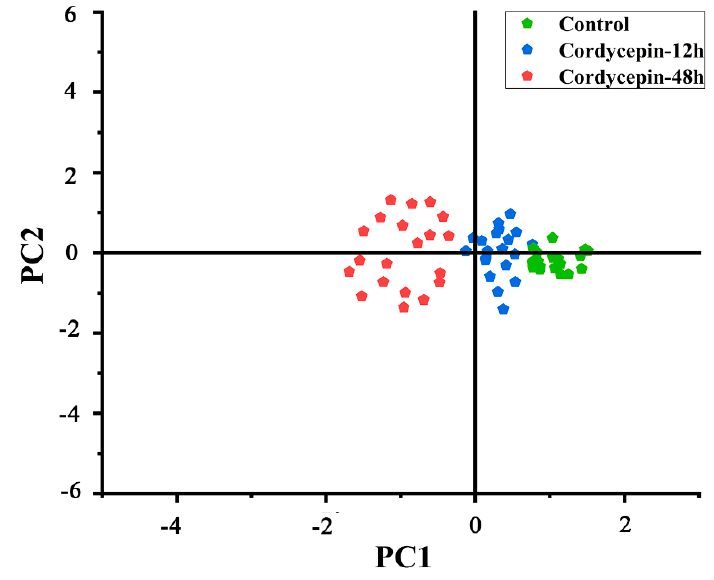
Figure 6. Scatter plots of the first two principal components (PCs) for the control group (green), cordycepin-12 h group (blue), and cordycepin-48 h group (red).